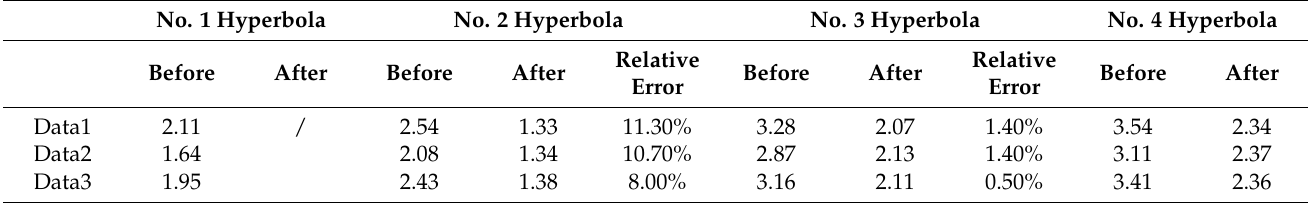
Figure 15. Manual labeling and curve fitting results. Table 6. Depth inversion results of the measured